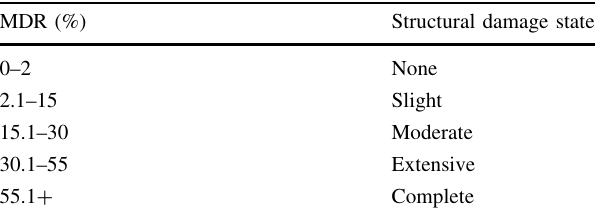
Table 1 Relationships between mean damage ratio (MDR) ranges and structural damage states